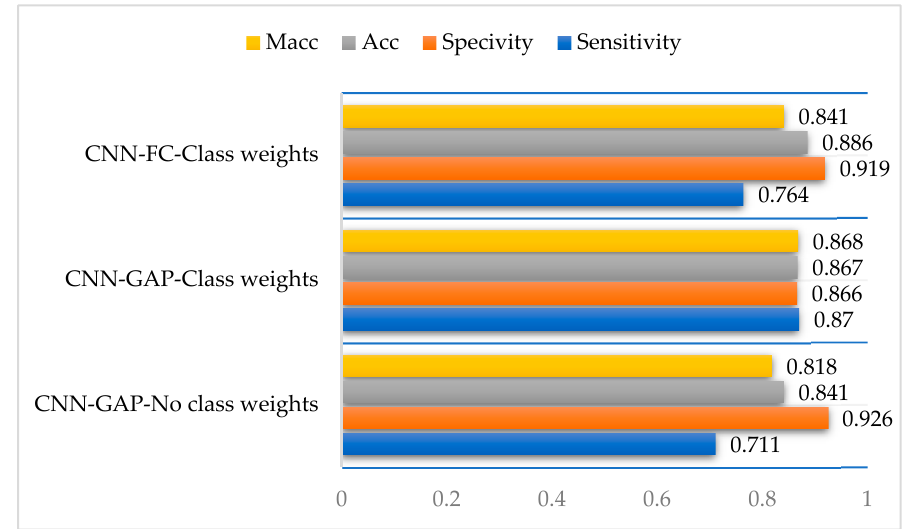
Figure 6. The comparison between the Acc and Macc in three different models, respectively .